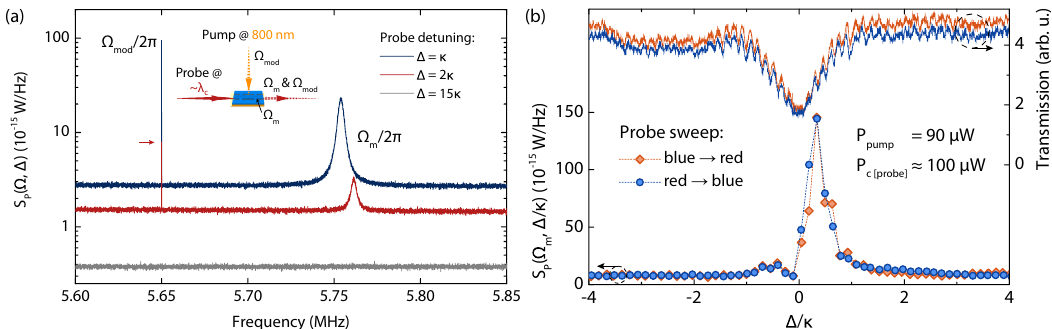
Figure 3. ( a ) Spectra of the probe light, as measured by the Electric spectrum analyser (ESA), coupled to the PhC cavity with a layer of QDs in the middle, pumped non-resonantly at normal incidence. The pump laser power is modulated at Ω mod /2 π . Shown curves are measured at different laser–cavity detunings ∆ = λ probe − λ 0 . The Lorentzian peak at Ω m /2 π corresponds to the fundamental flexural mode of the membrane (membrane size: 8.5 × 4.8 × 0.26 µ m). Inset: schematic describing the origin of the two detected peaks; ( b ) (bottom) Mechanical M 1 mode amplitude dependence on probe laser detuning, acquired for forward (blue- to red-detuned) and backward (red- to blue-detuned) scanning directions. (top) Waveguide transmission spectra for both probe sweep directions. Measurements in ( b ) were performed at the same probe laser power (corresponding to the intracavity power P c ≈ 100 µ W) and pump laser power P pump = 90 µ W; at room temperature T b = 294 K and at low pressure p < 10 − 4